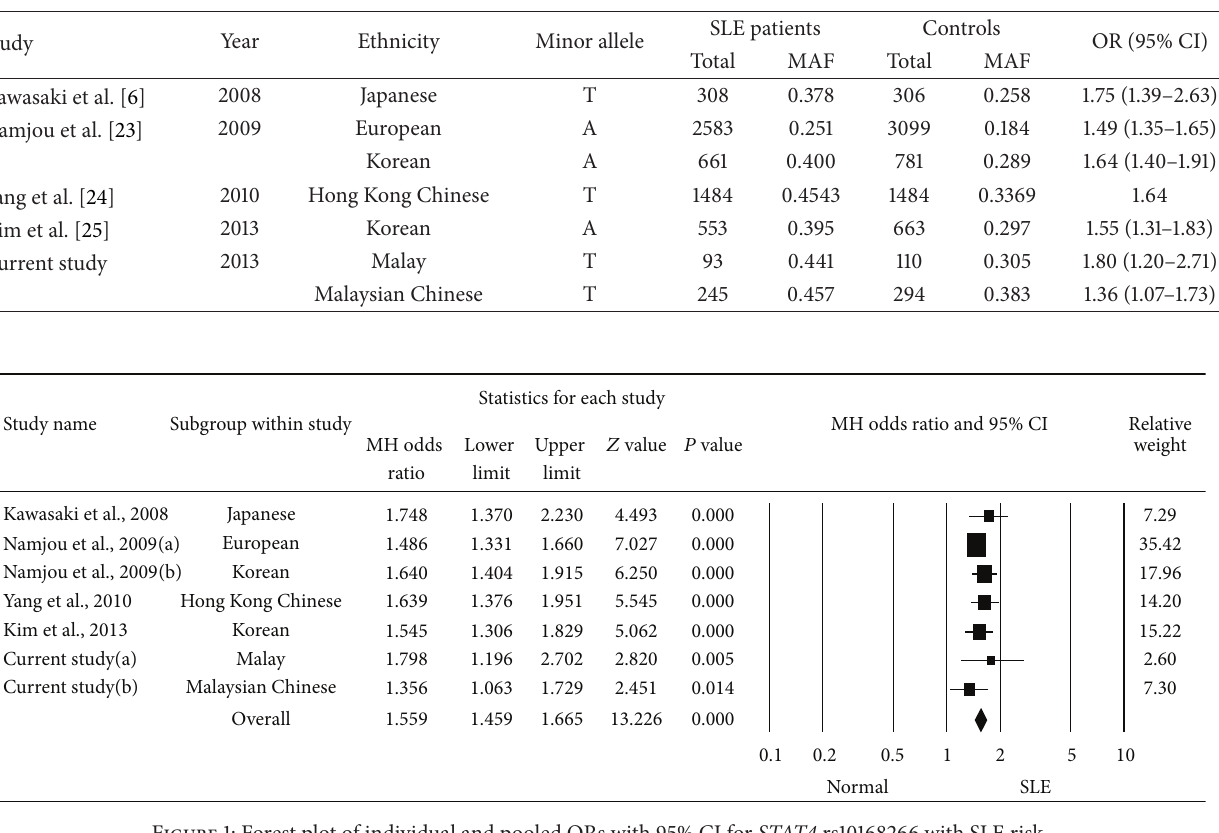
Table 6: Main data extracted from the studies included in the meta-analysis of STAT4 rs10168266.